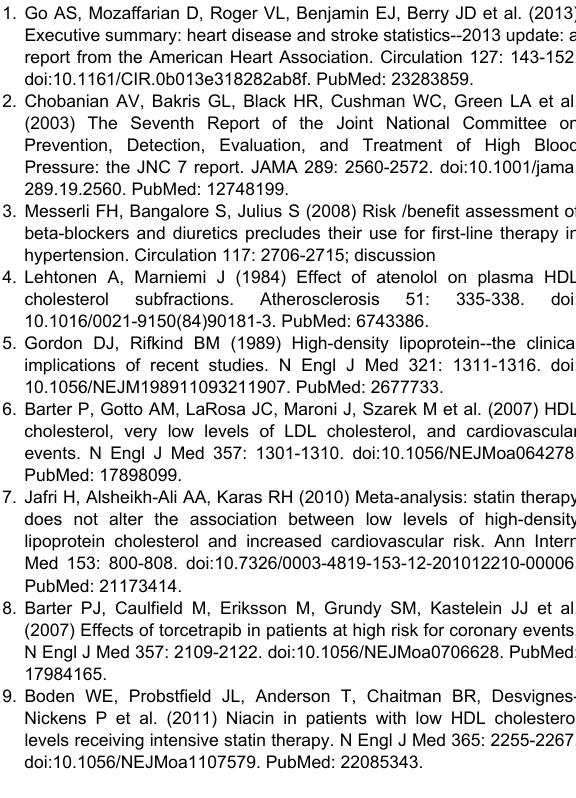
Table S2. Top gene regions associated with atenolol induced changes in HDL-C. Data reflect top regions after a sensitivity analysis removing one White participant with an extreme HDL-C response. *P-value from sensitivity analysis after removing 1 White participant with an extreme HDL-C response. MA: Minor Allele; MAF: Minor Allele Frequency.